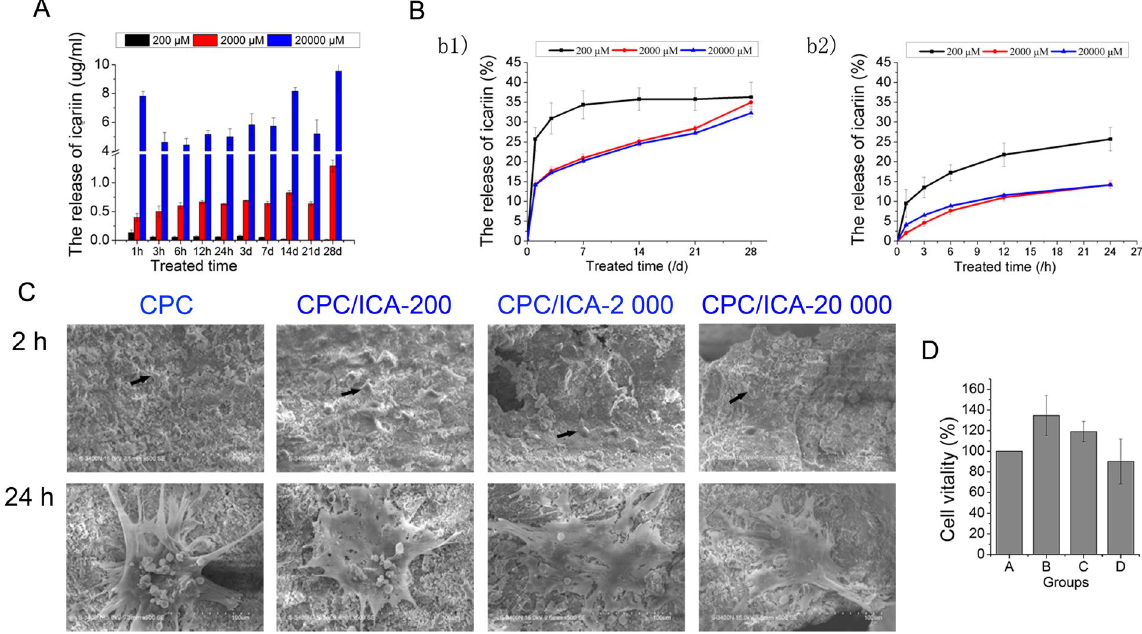
Figure 3. Release of icariin loaded in CPC at concentrations of 200, 2 000 and 20 000 μ M, and the morphology, adhesion, and proliferation of BMSCs seeded on CPC with or without icariin. ( A ) Absolute release amount. ( B ) Cumulative release of icariin in percent. ( C ) SEM analysis of BMSCs seeded on samples CPC, CPC/ICA-200, CPC/ICA-2 000, CPC/ICA-20 000 for 2 h and 24 h. Scale bar = 100 μ m. ( D ) The vitality of BMSCs on samples CPC, CPC/ICA-200, CPC/ICA-2 000 and CPC/ICA-20